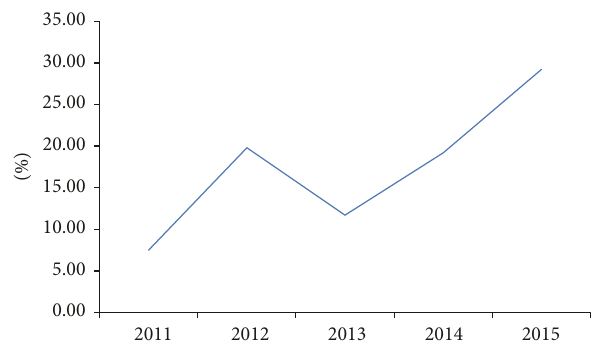
Figure 2: Intestinal parasitic infections’ repartition according to age